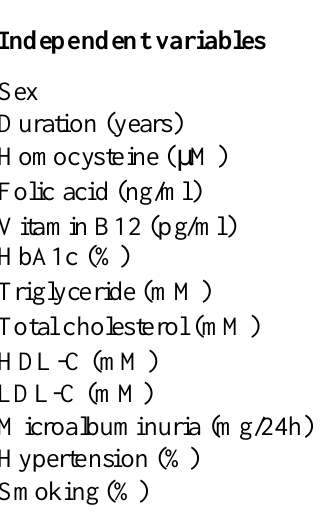
Table 3.: Logistic regression of predictors of retinopathy in individuals with type 2 diabetes. N.S. = not signifi-